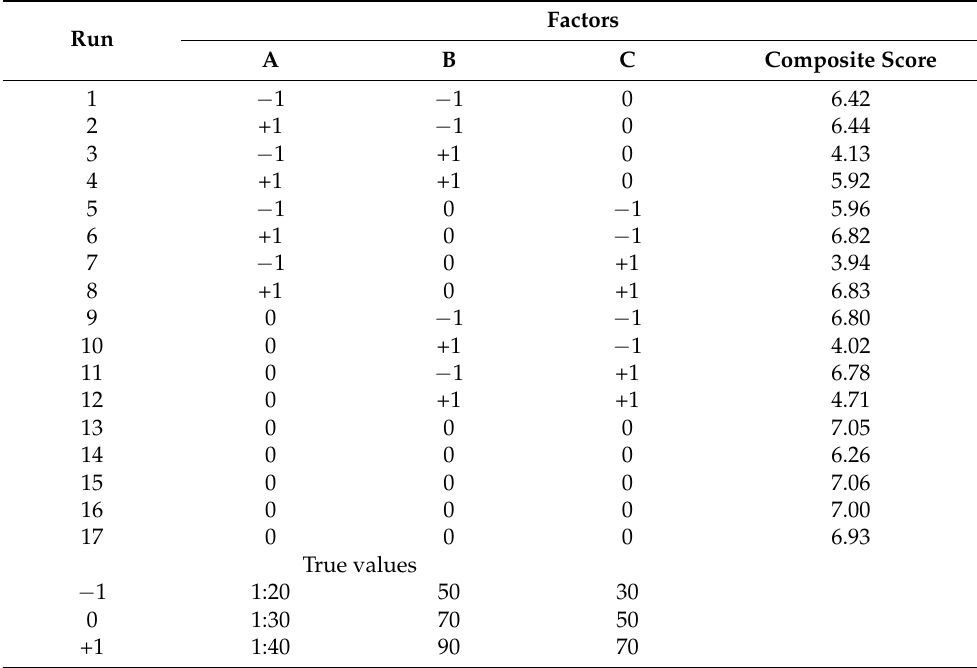
Table 1. BBD applied for flavonoids extracts from Semen Hoveniae